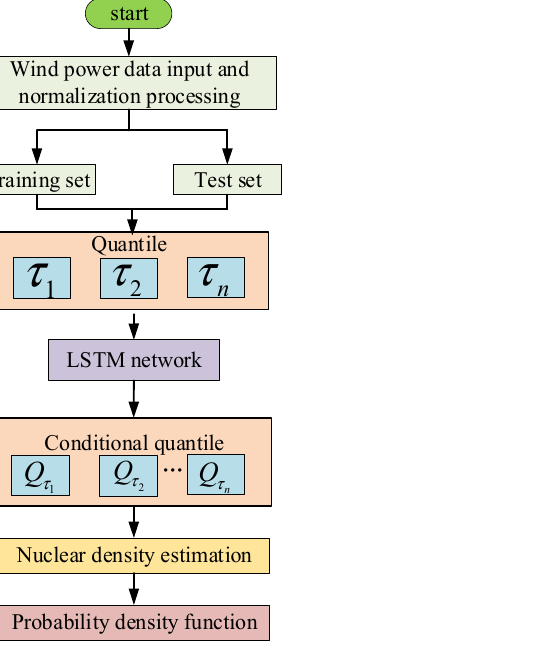
Figure 2. Quantile regression LSTM wind-power prediction process.